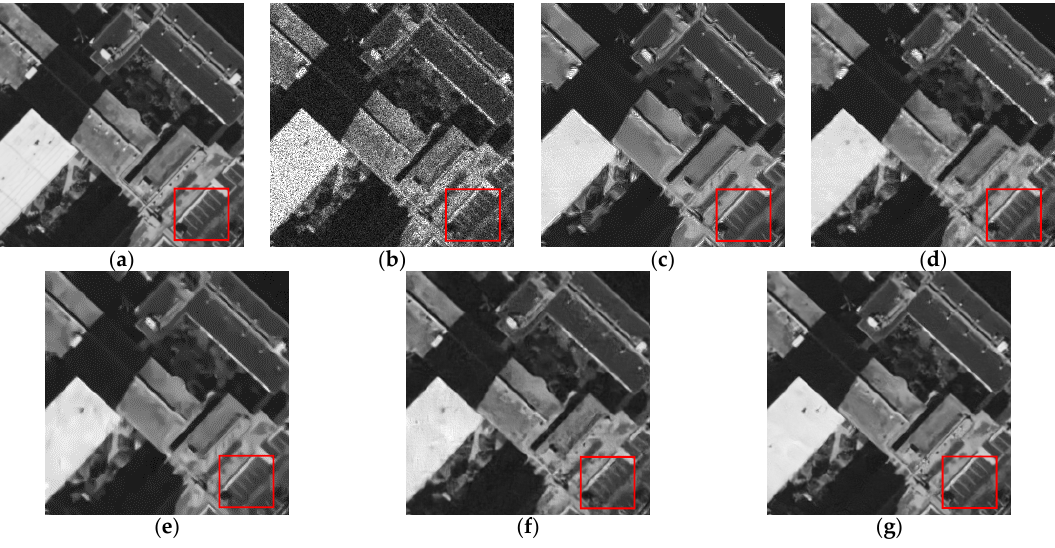
Figure 7. Filtered images for the Building image contaminated by four-look speckle. ( a ) Original image. ( b ) Speckled image. ( c ) PPB [13]. ( d ) SAR-BM3D [14]. ( e ) SAR-POTDF [16]. ( f ) SAR-CNN [28]. ( g ) SAR-DRN.